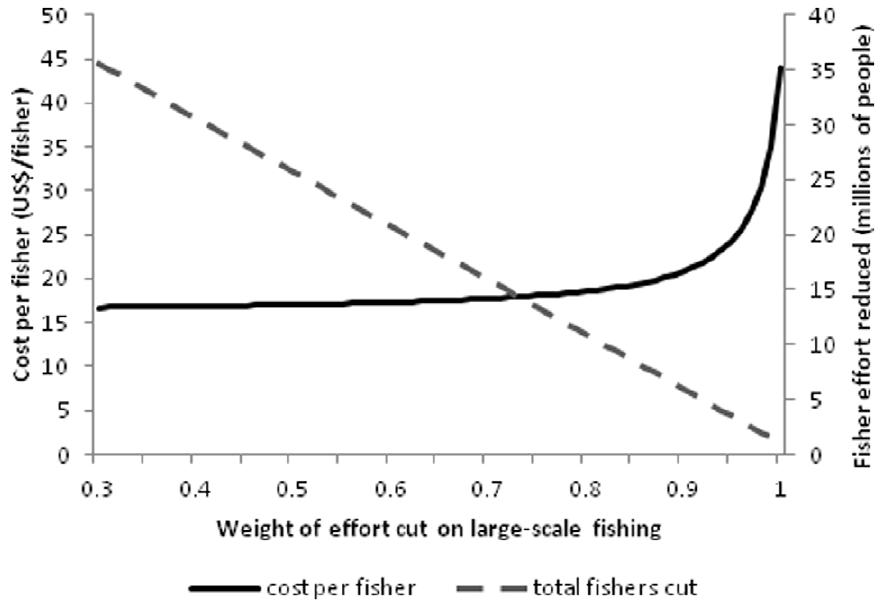
Figure 6. Trade-offs between reductions in cost of fishing effort and total fishing effort (in terms of number of fishers) reduced as the weight of effort cuts on large-scale fishing varies.